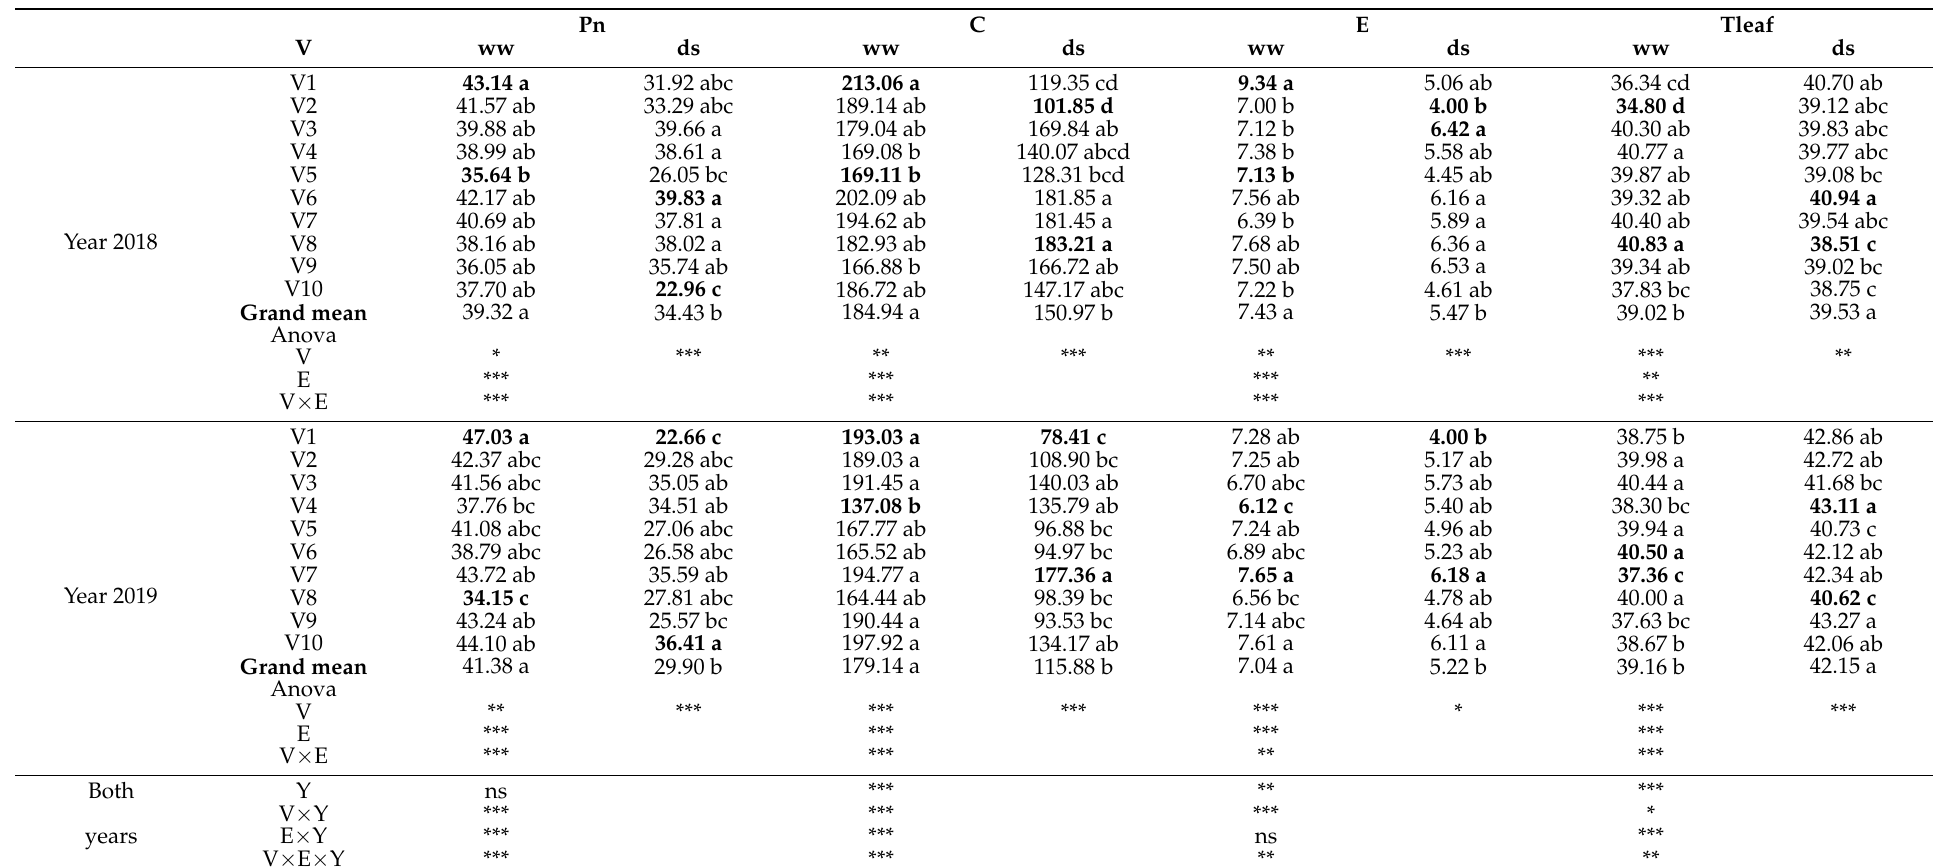
Table 5. Variety and environment per se performance compared among ten sorghum varieties and two water treatments (well-watered and drought stress) for agrophysiological traits measured during 2018 and 2019 field